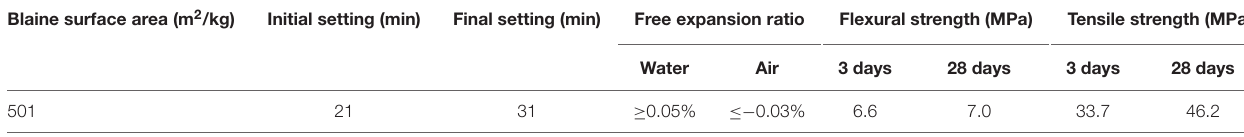
TABLE 1 | Technical index of the used HB-CSA cement.